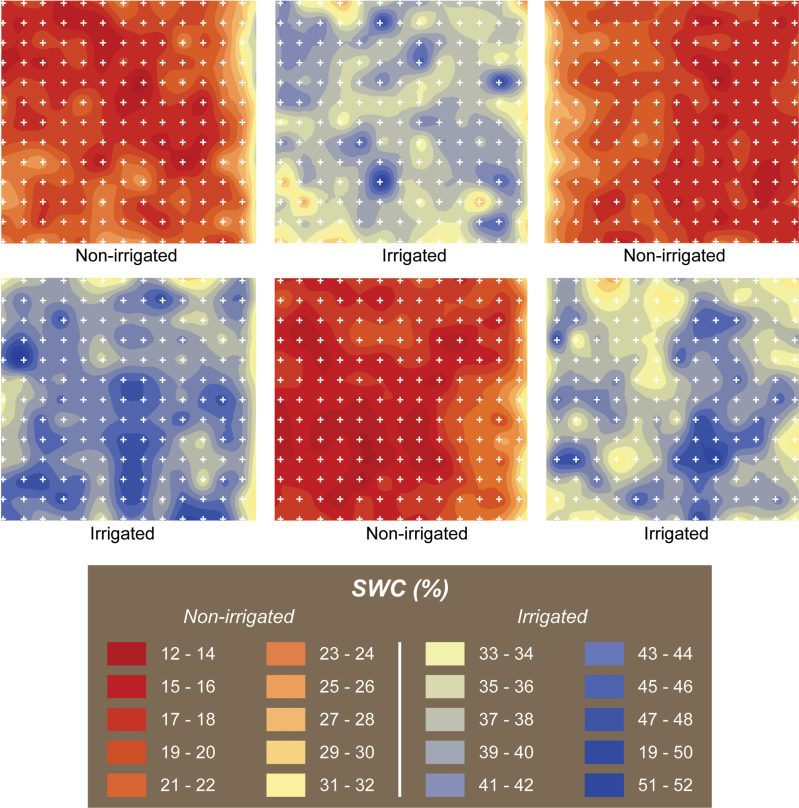
Variation in volumetric SWC (%) across the experimental sites 63 days after the drought treatment was applied at Palmerston North. Each white cross represents a measurement location.